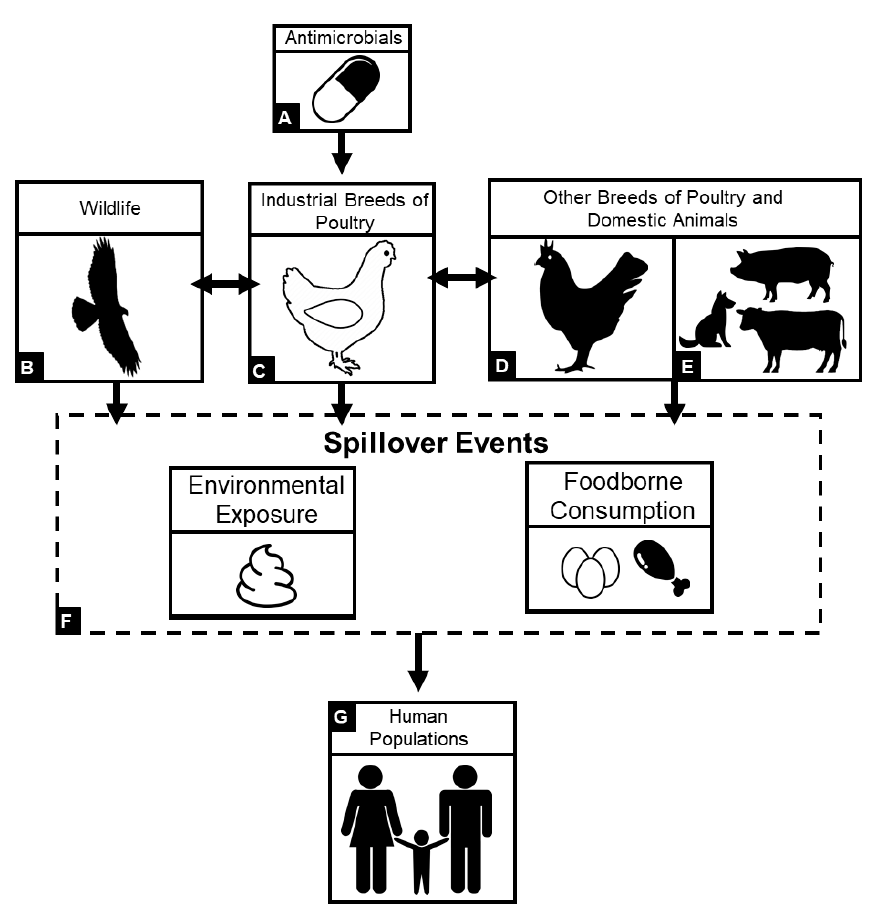
Figure 6. Conceptual graphic illustrating antimicrobial resistance associated with intensive poultry production. Table 4. Overview of antimicrobial resistance (AMR) transmission pathways originating from poultry production within resource-limited settings.